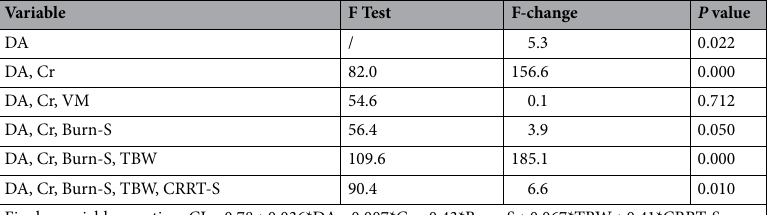
Table 3. Covariates for CL screened by the stepwise method. Increases in the F value (F-change) represent the degree of influence of the addition of the corresponding covariate on CL ( P < 0.05 retained the corresponding covariate; P > 0.05 deleted the corresponding covariate).